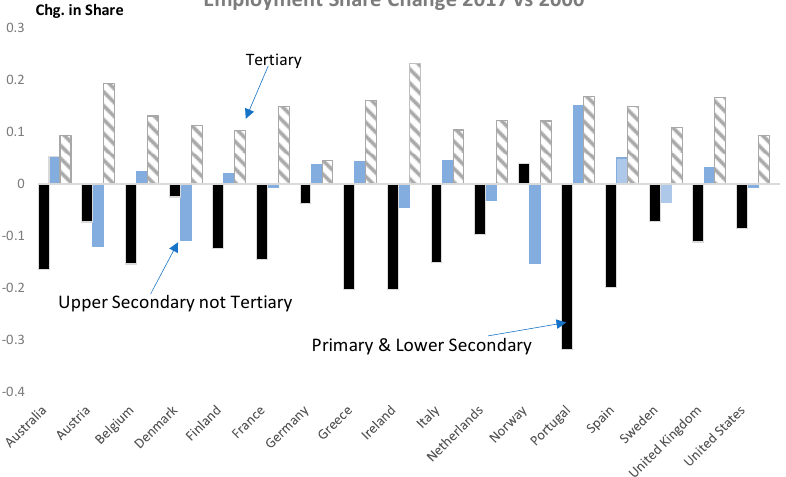
Figure 3. Change in the Share of Employment by Education Category, between 2000 and 2017. Source: National sources.